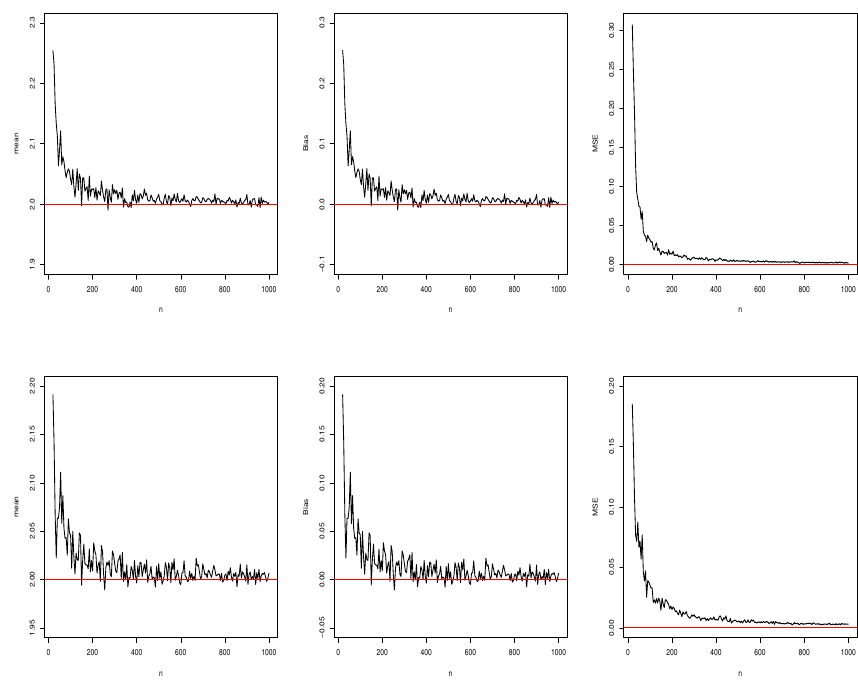
Figure 6. The results of the α ( top ) and β ( bottom ) parameters for the simulation-II.